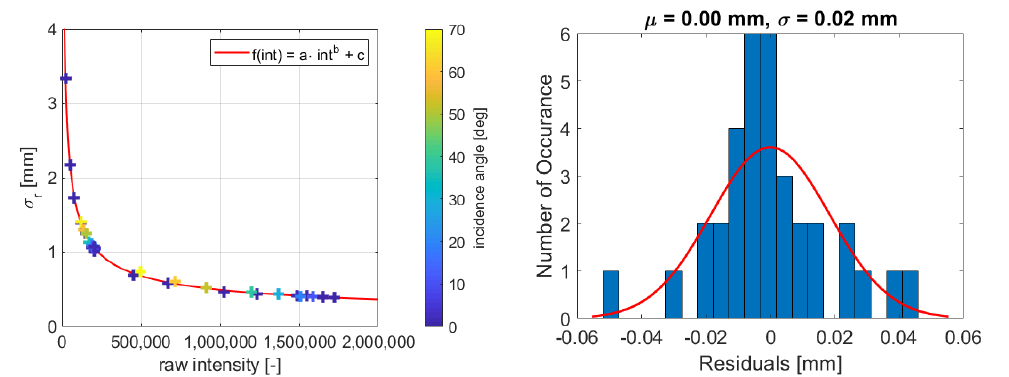
Figure 5. Left : Estimated function for HDS6100 and scan rate of 508 kHz; Right : Corresponding histogram of the residuals of the